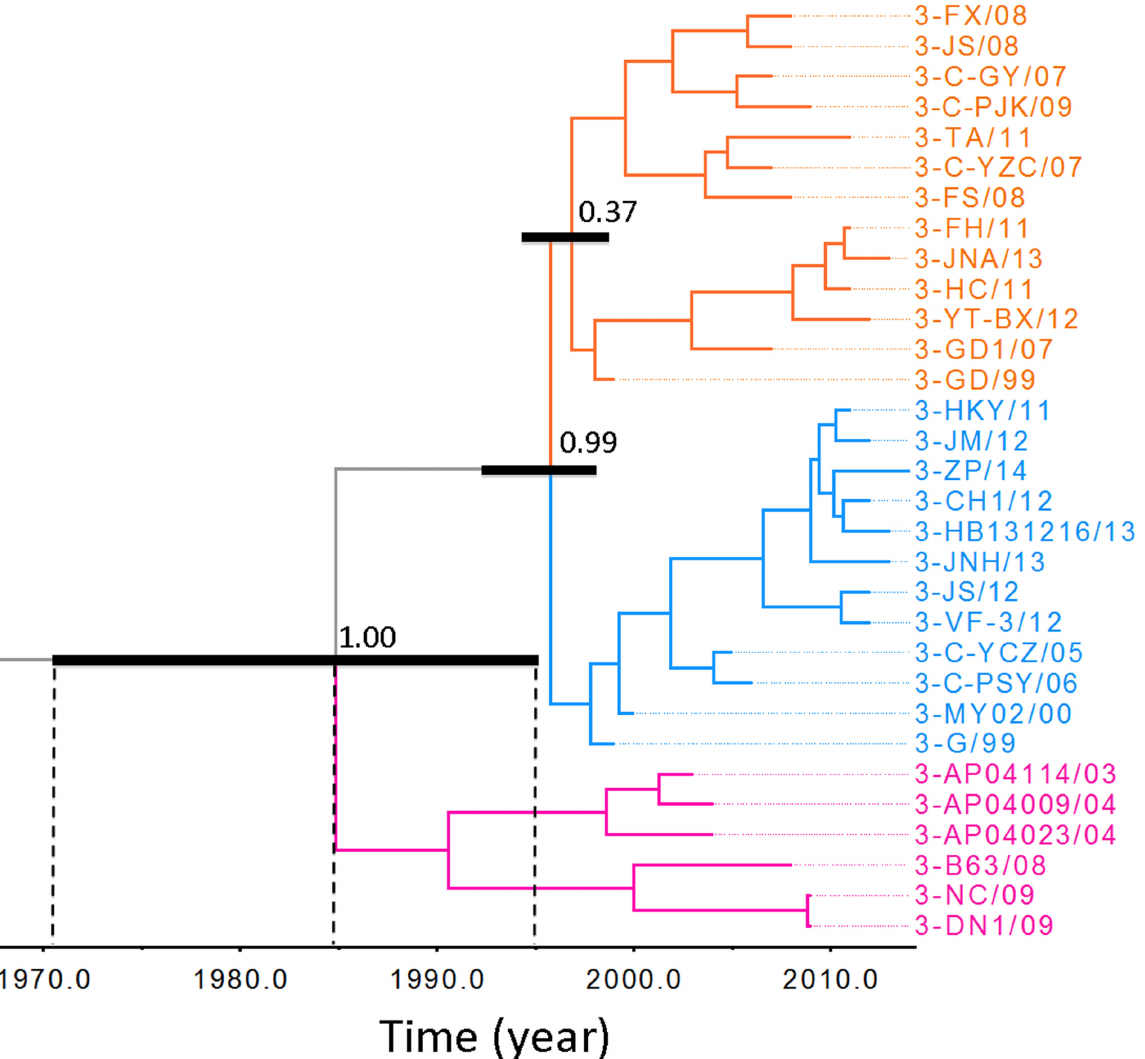
Fig 2. Bayesian Maximum Clade credibility tree of VP1 gene of DHAV-3 virus. The orange and blue colored branches represent one lineage while pink colored branches represents the other lineage. The probabilities of the most internal nodes were shown. The inferred divergence time was shown below the tree. The black bar represents 95% high probability interval for the most recent common ancestor. Virus strains were named in the order of serotype, abbreviations of isolation place and two digits isolation time. See materials section and Table 1 for abbreviations of isolates and their locations.